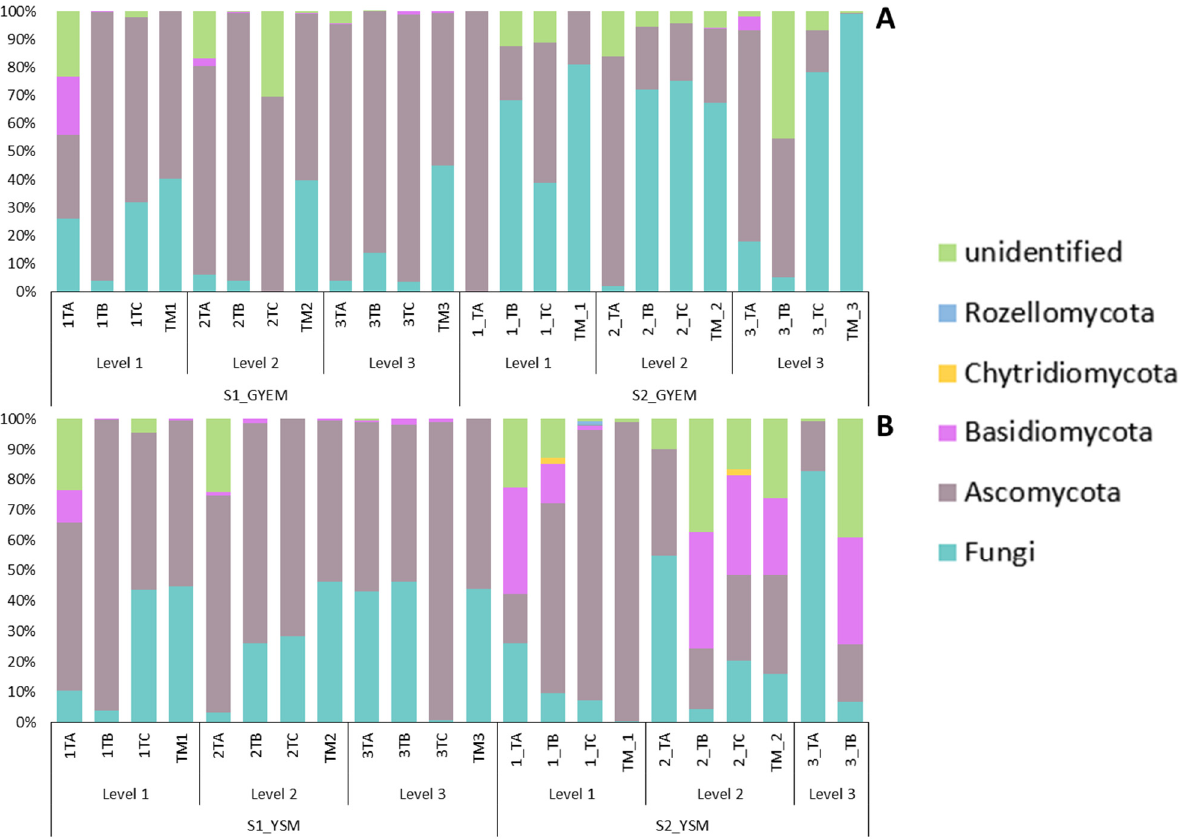
Figure 4. Relative abundance of fungi at phyla depth: ( A )—glucose yeast extract media and ( B )— yeast sucrose media.